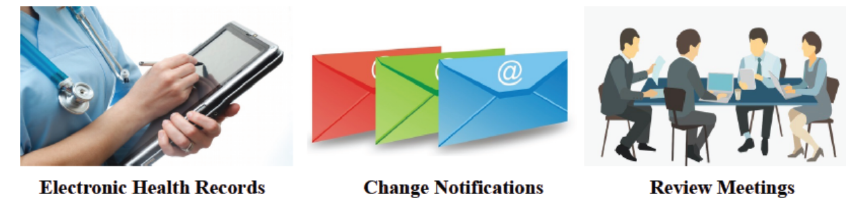
Figure 9. Correlation of detected changes with medical observations.